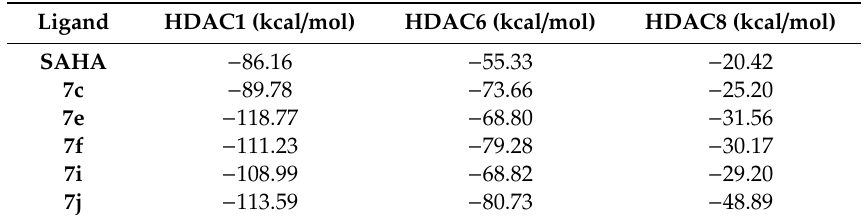
Table 4. Interaction energies ( ∆ G) of molecules docked into the active site of HDACs isoforms.